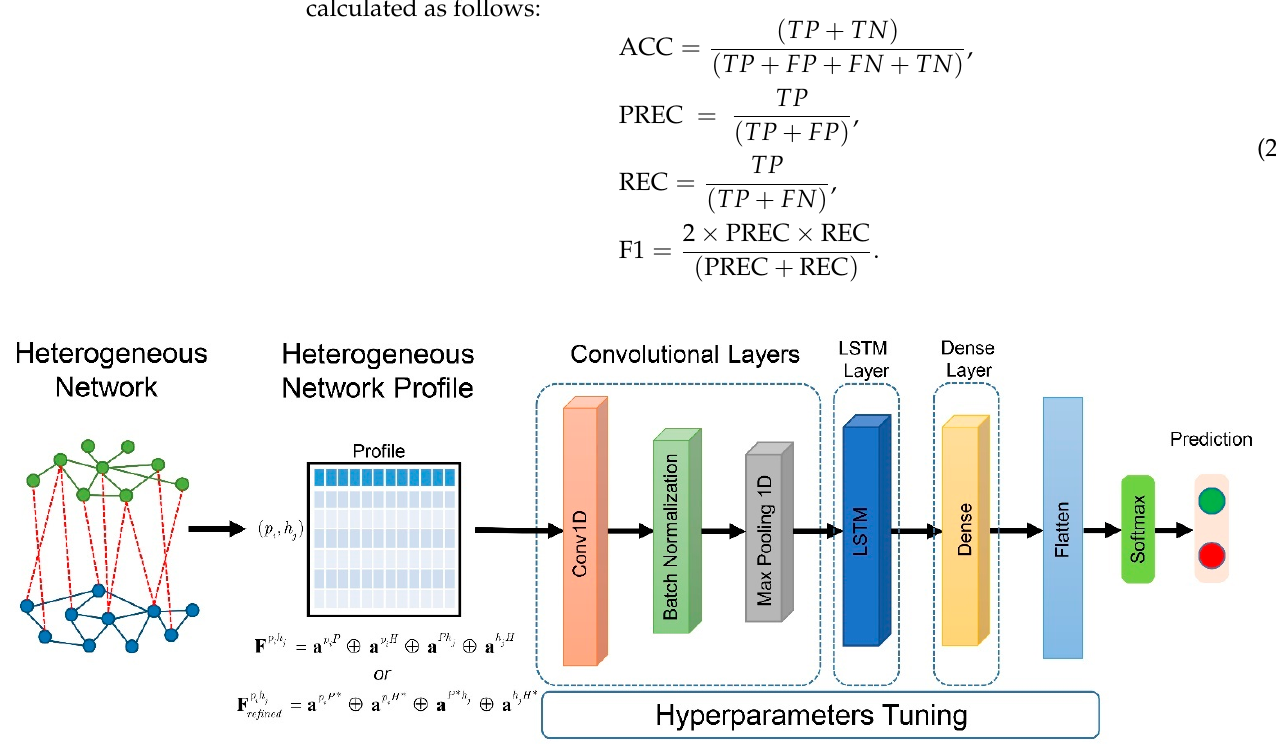
Figure 7. Overview of the analytical framework. Heterogeneous network of human and P. falciparum is constructed. Network profiles are extracted from the heterogeneous network. The network profiles are fed to the hybrid deep learning system to predict the orthologous genes between humans and P. falciparum .